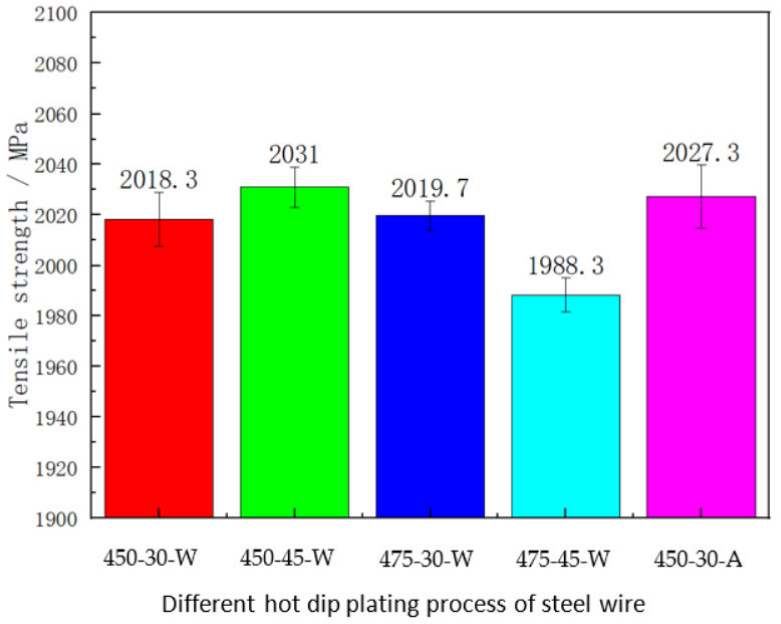
Figure 7. Tensile strength of steel wires with different hot dip plating process